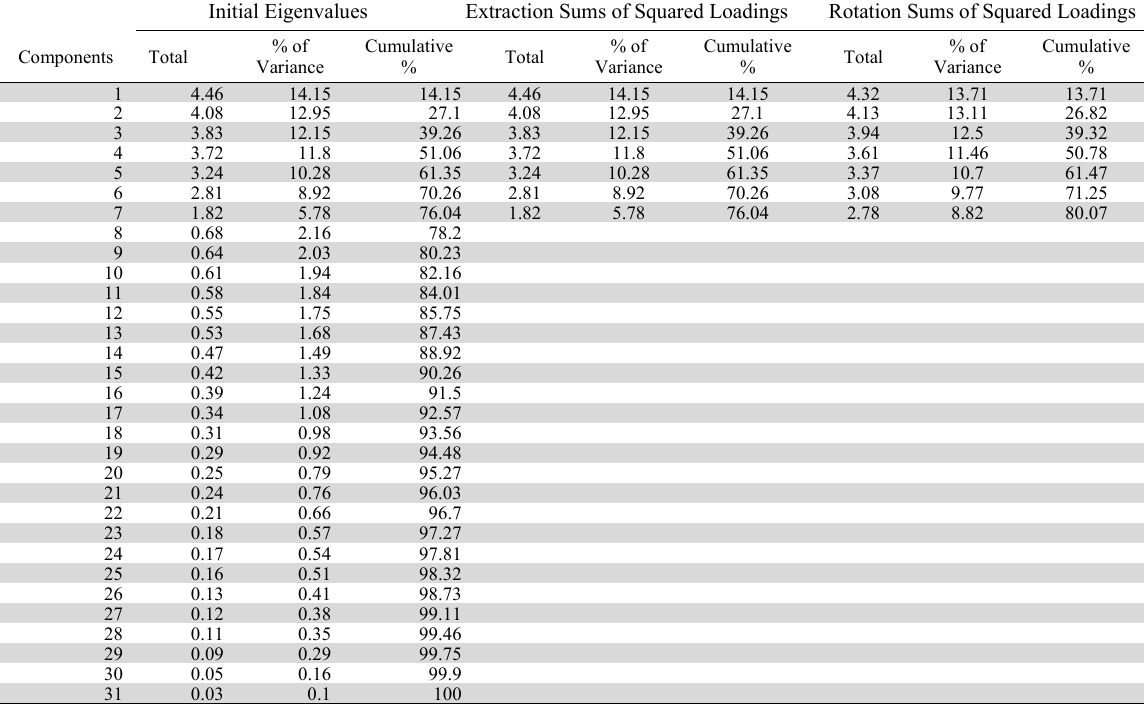
Initial Eigenvalues